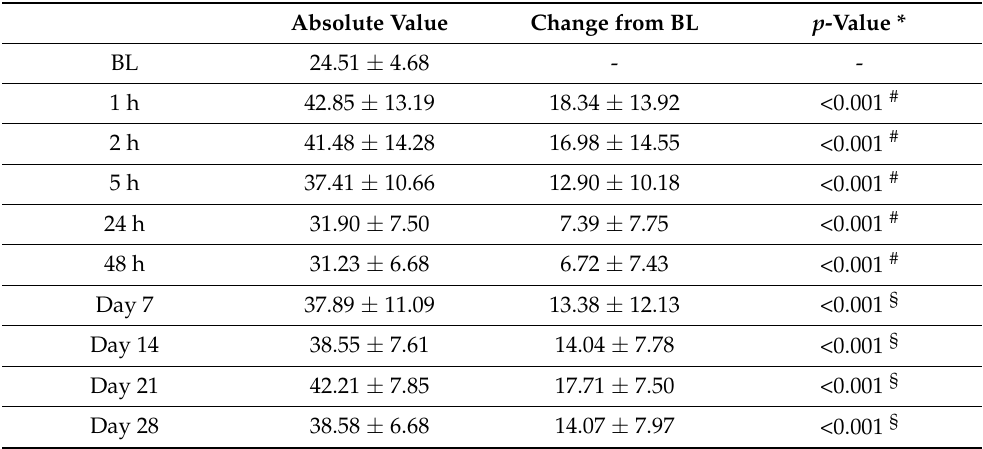
N = 42. Data are given in arbitrary units (a.u.). The values were assessed by corneometry in area A1 (= treated with Emollient 1) and are presented as mean ± SD. BL = Baseline skin capacitance value before first product application; h = hour. * For mean change from baseline, paired t -test. # Significant if p < 0.01 (Bonferroni correction). § Significant if p < 0.0125 (Bonferroni correction). Note: An increase in skin capacitance reflects a skin-hydrating effect.